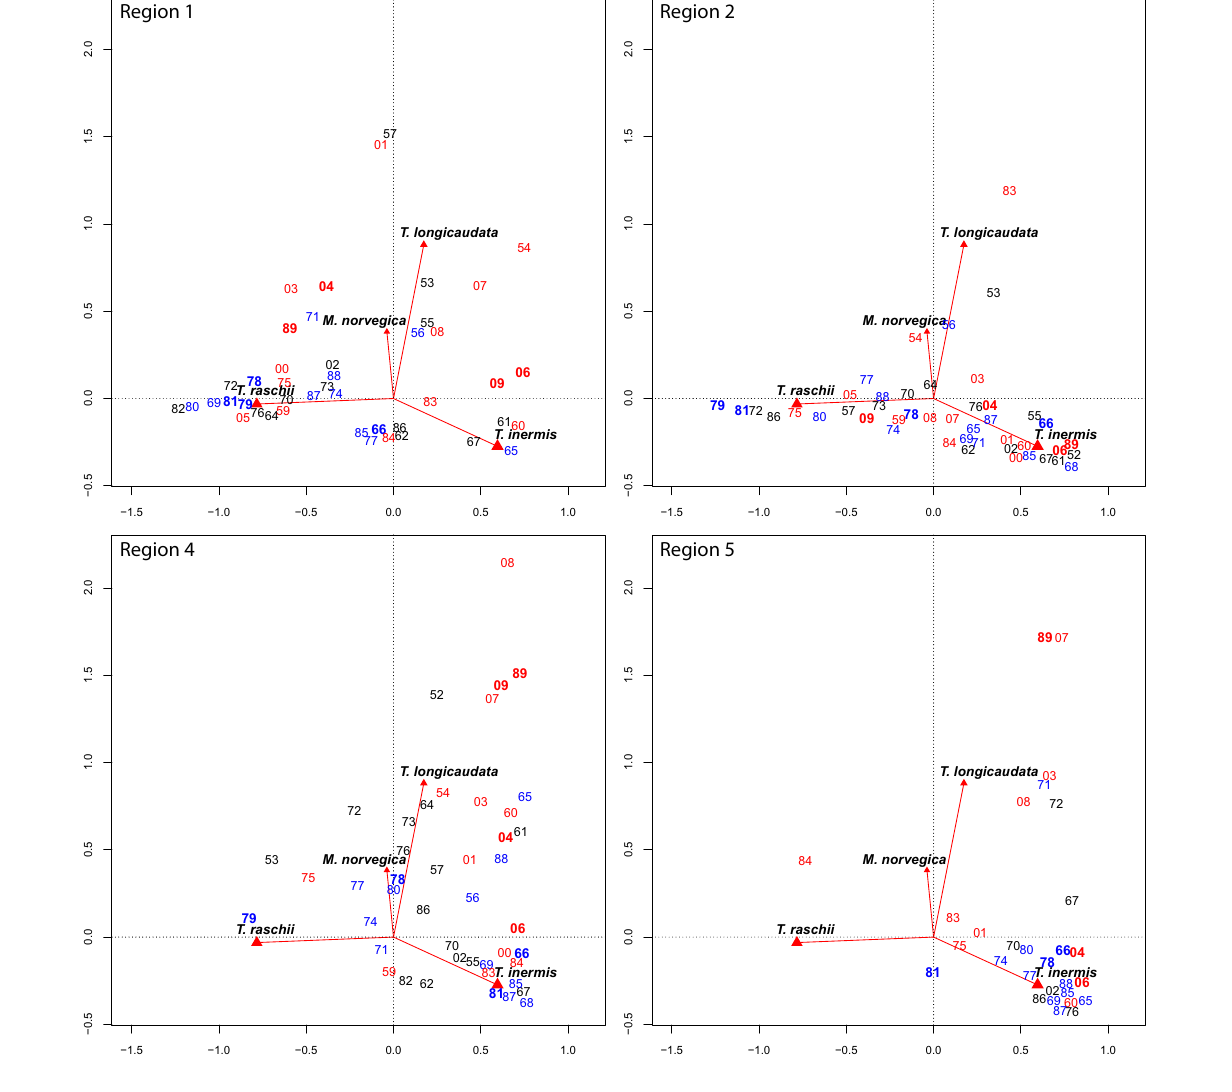
indicates cold, and years in dark bold blue are very cold as indicated by the Kola Transect temperature anomaly (see Results text for more details). Other labels and how to read these plots as described for Figure 3